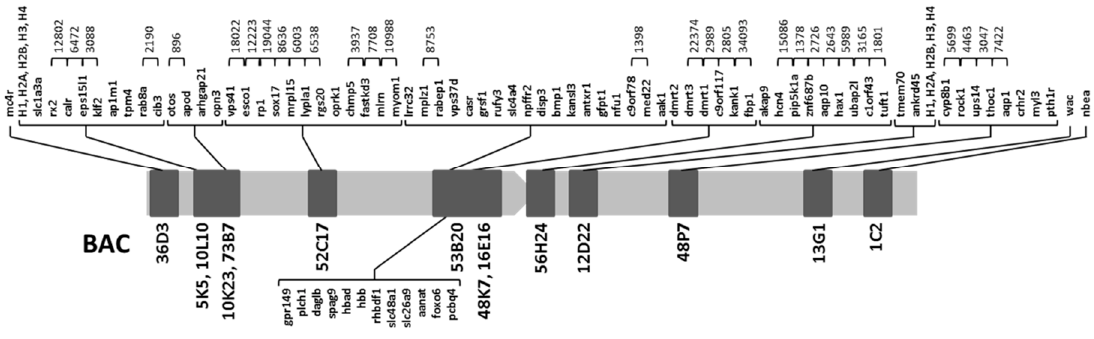
Figure 2. Integrated genetic map of metacentric chromosome 1 of S. senegalensis .